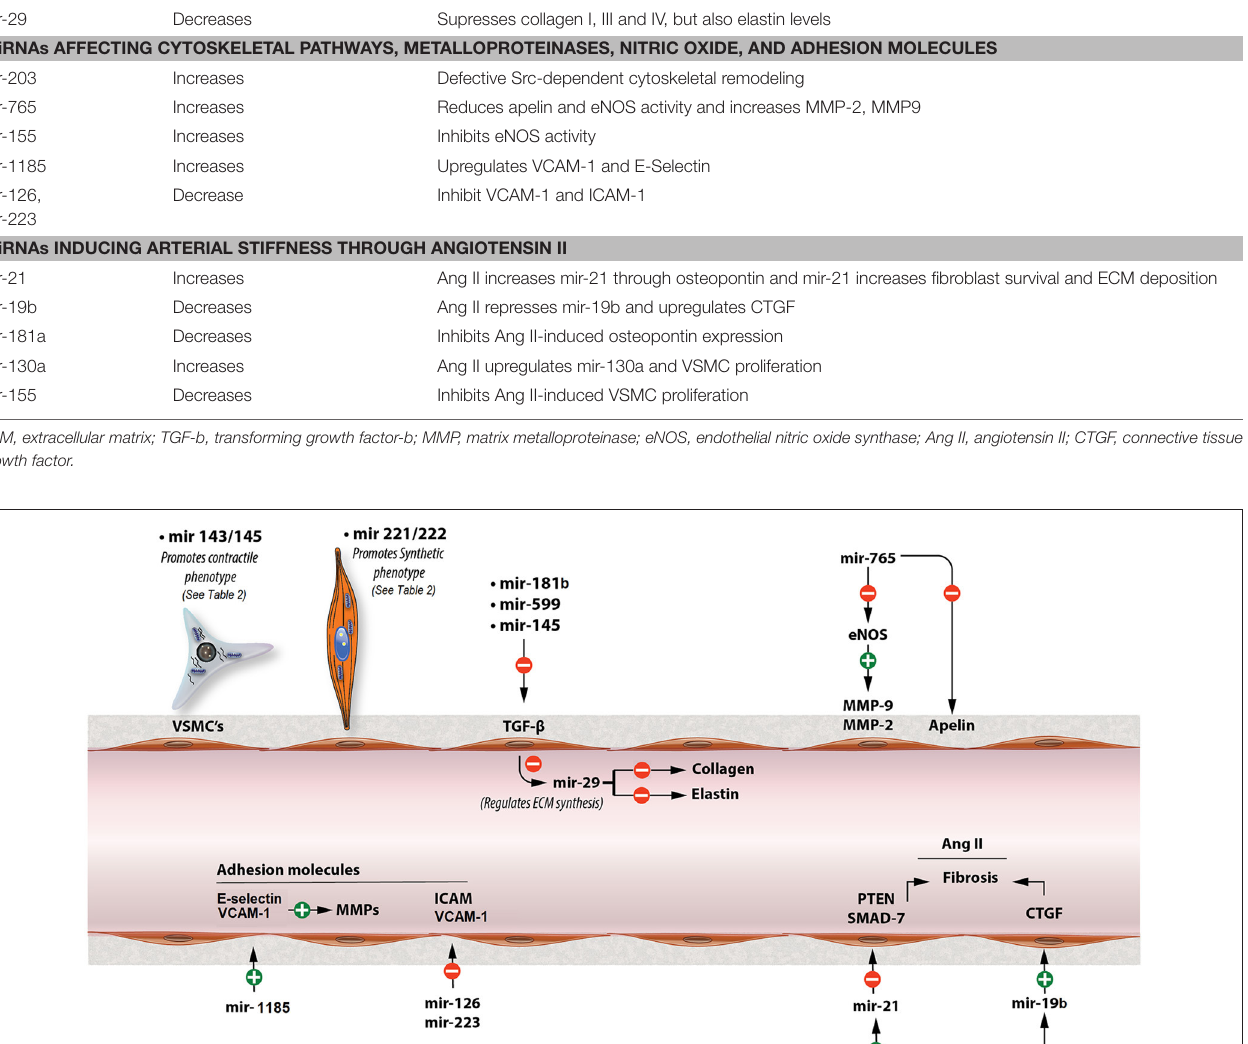
TABLE 1 | miRNAs influencing biological pathways of arterial stiffness. miRNA Arterial stiffness Function miRNAs AFFECTING EXTRACELLULAR MATRIX PROTEINS mir-181b Decreases Inhibits TGF- β signaling and ECM production mir-599 Decreases Inhibits TGF- β signaling and ECM production mir-145 Inhibits TGF- β signaling and ECM